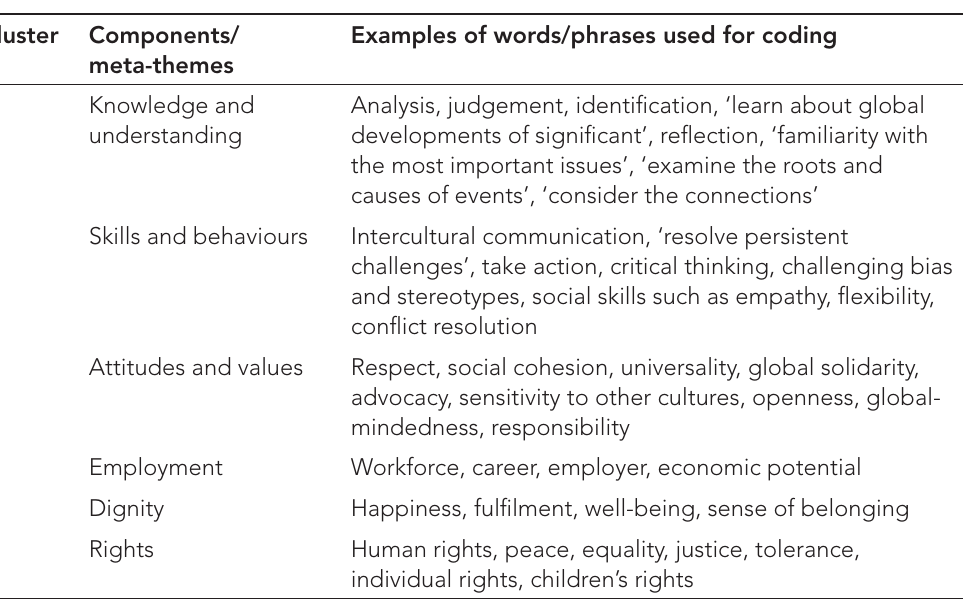
Table 1: Cluster 1 and 2 codes Cluster Examples of words/phrases used for